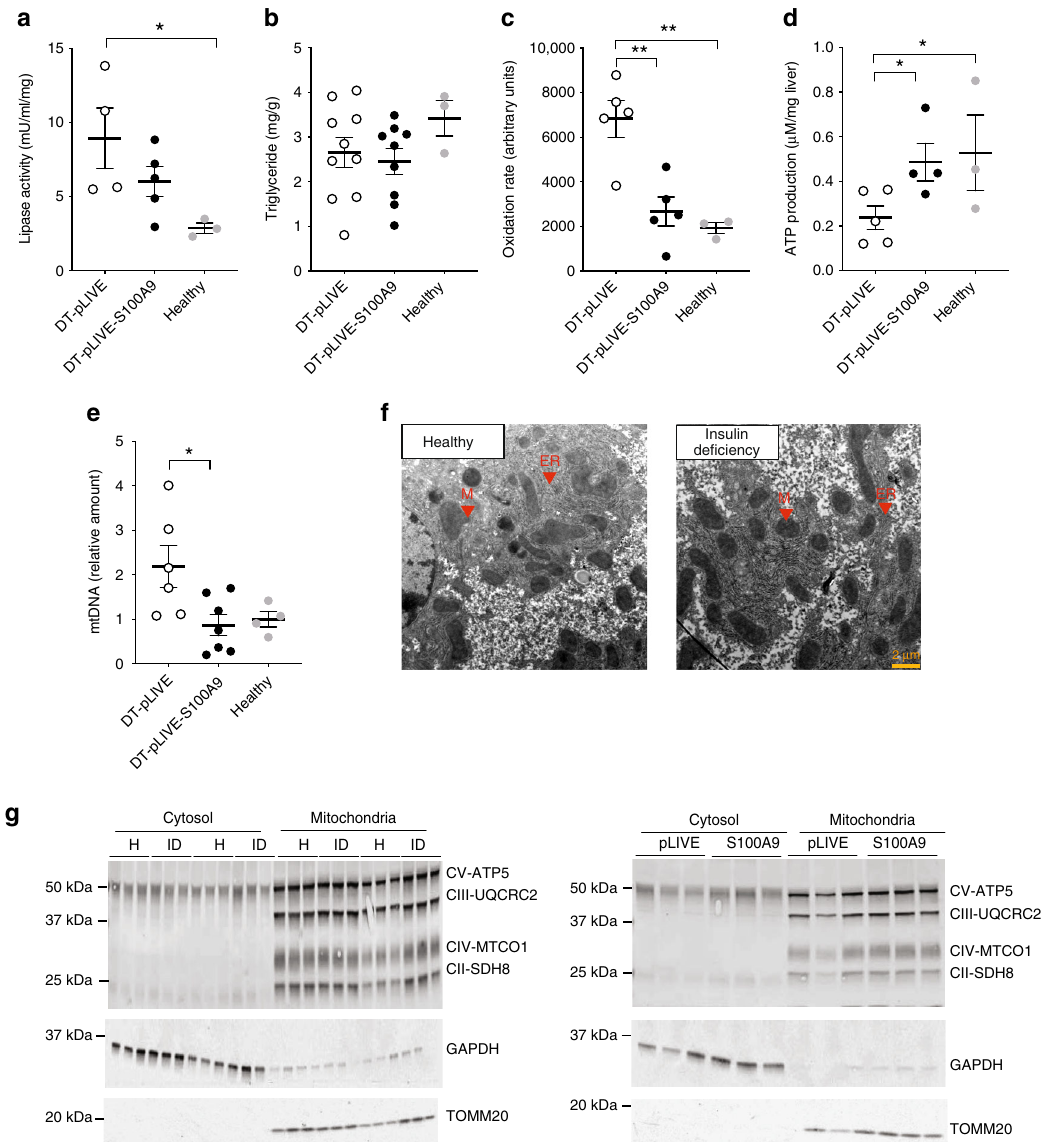
Fig. 4 S100A9 dampens hepatic fatty acid oxidation in ID. In DT-pLIVE and DT-pLIVE-S100a9 (10 days after HTVI injection), and their age-matched healthy controls: a lipase activity in perigonadal adipose tissue ( n /group = 4, 5, and 3), b hepatic triglycerides ( n /group = 10, 9, and 3), c hepatic fatty acid oxidation rate (using 14 C-palmitic acid) ( n /group = 5, 5, and 3), d hepatic ATP content ( n /group = 5, 4, and 3) and e hepatic mitochondrial DNA copy number ( n /group = 5, 6, and 4). f Mitochondrial morphology; representative transmission electron microscopy pictures of liver of healthy and insulin de fi cient mice. M (mitochondria), ER (Endoplasmatic Reticulum). g Protein levels of different subunits of oxidative phosphorylation complexes (Complex II = CII, Complex III = CIII, Complex IV = CIV, Complex V = CV) and import receptor TOMM20 in isolated hepatic mitochondria from healthy, insulin de fi cient (ID), DT-pLIVE and DT-pLIVE-S100A9 mice. Error bars represent SEM. Statistical analyses were done using one-way ANOVA (Tukey ’ s post hoc test). * P < 0.05; ** P < 0.01. Source data are provided as a Source Data fi